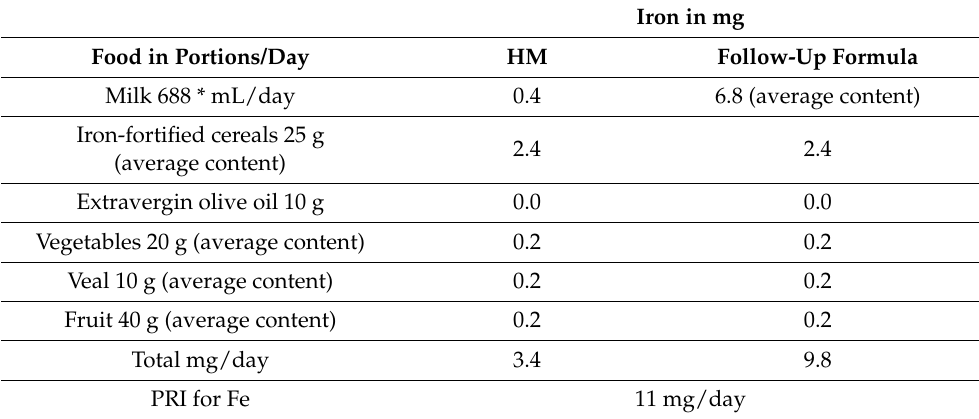
Table 3. Different iron intake for a 6–8-month-old infant weighing between 7.3 and 8.6 kg [32] when breastfed or formula-fed, considering only one single complementary feeding scheme and an iron PRI of 11 mg/day [35]. The amount of milk * is defined according to Dewey’s observational data [7]. Iron in mg Food in